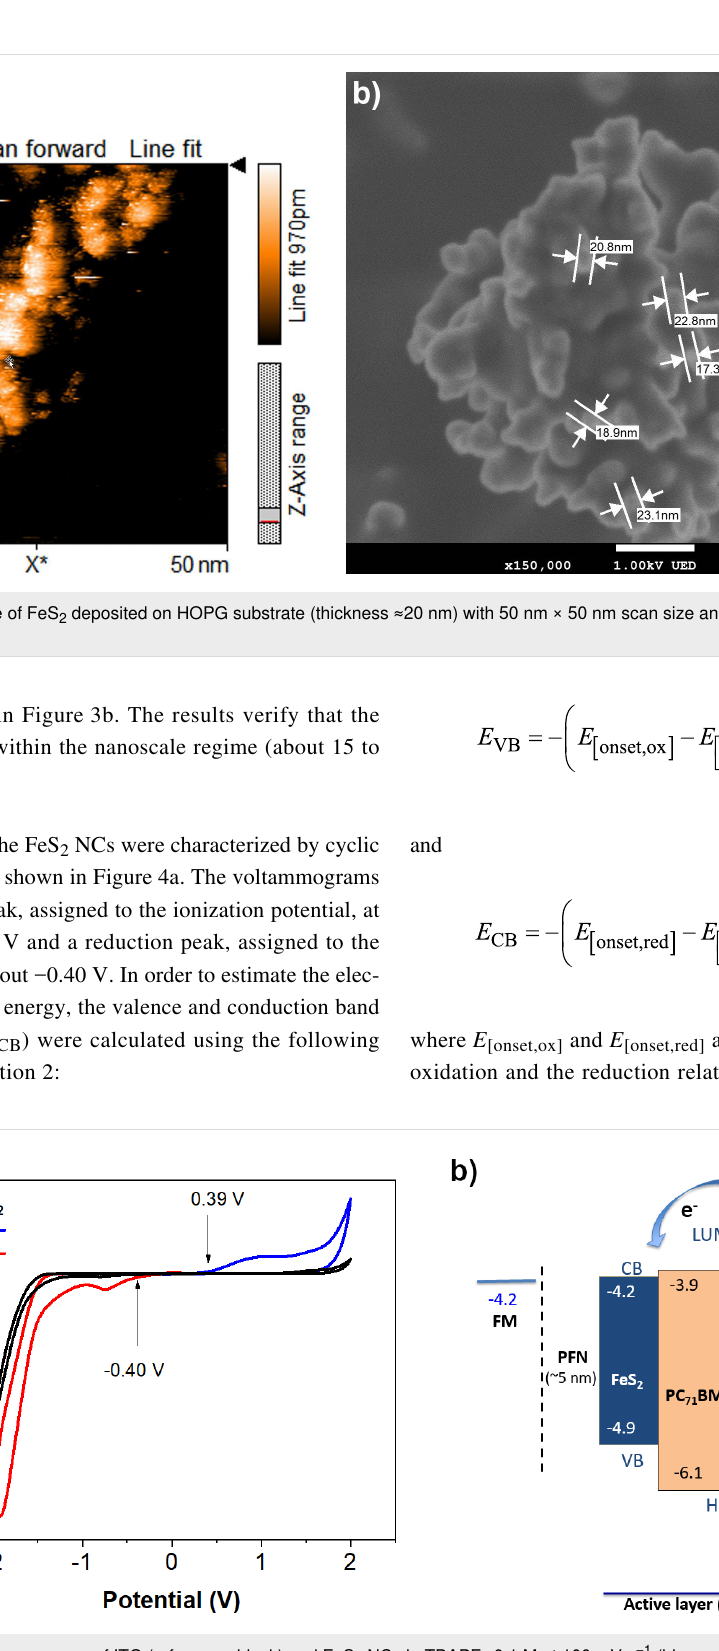
Figure 4: a) Cyclic voltammograms of ITO (reference, black) and FeS 2 NCs in TBAPF 6 0.1 M at 100 mV s − 1 (blue: anodic zone, red: cathodic zone). b) Flat energy diagram of the organic materials and FeS 2 used for OPV fabrication [21].